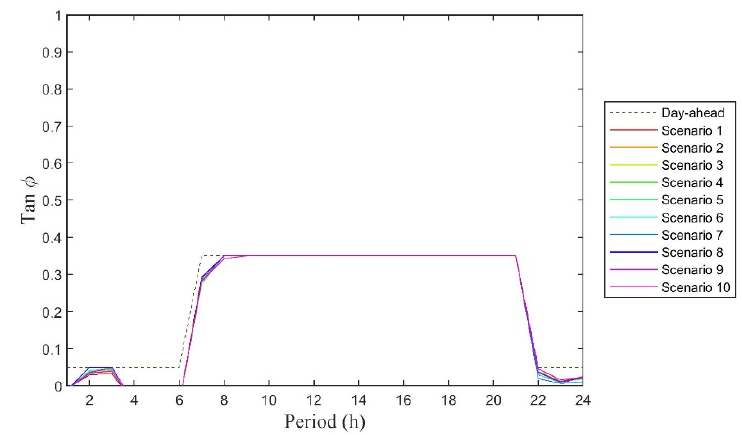
Figure 4. Forecasted and realized tan ϕ of the wind power plant 1 throughout 24 hours.